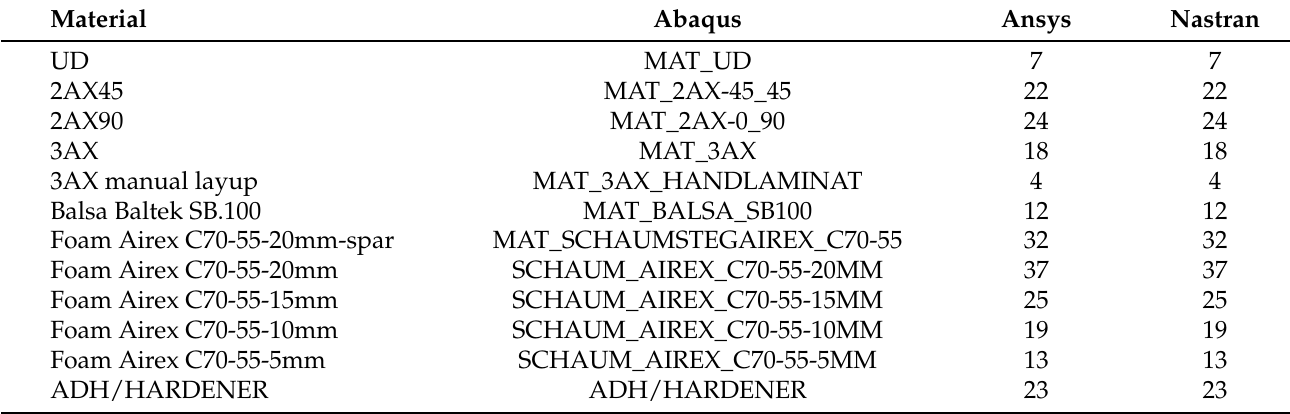
Table 5. Material numbers in the finite element models.